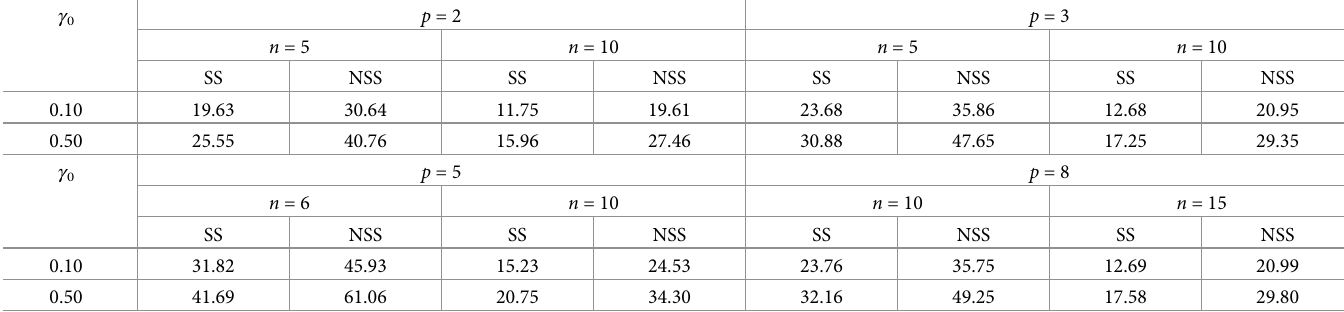
Table 7. A comparison of the EARL of the multivariate SS and NSS charts for p 2 {2,3,5,8}, n 2 {5,6,10,15} and γ 0 2 {0.10,0.50}, where ( τ min , τ max ) =